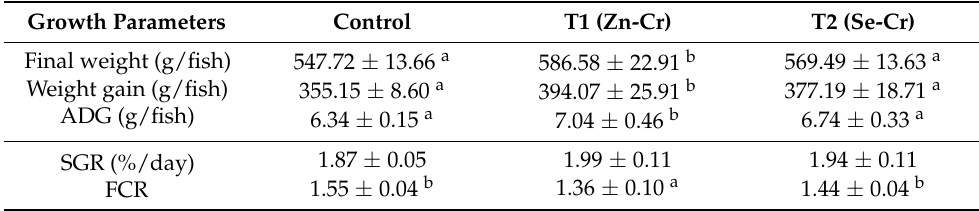
Table 2. Growth performance of red tilapia that were fed diets with different trace minerals for 8 weeks (mean ±